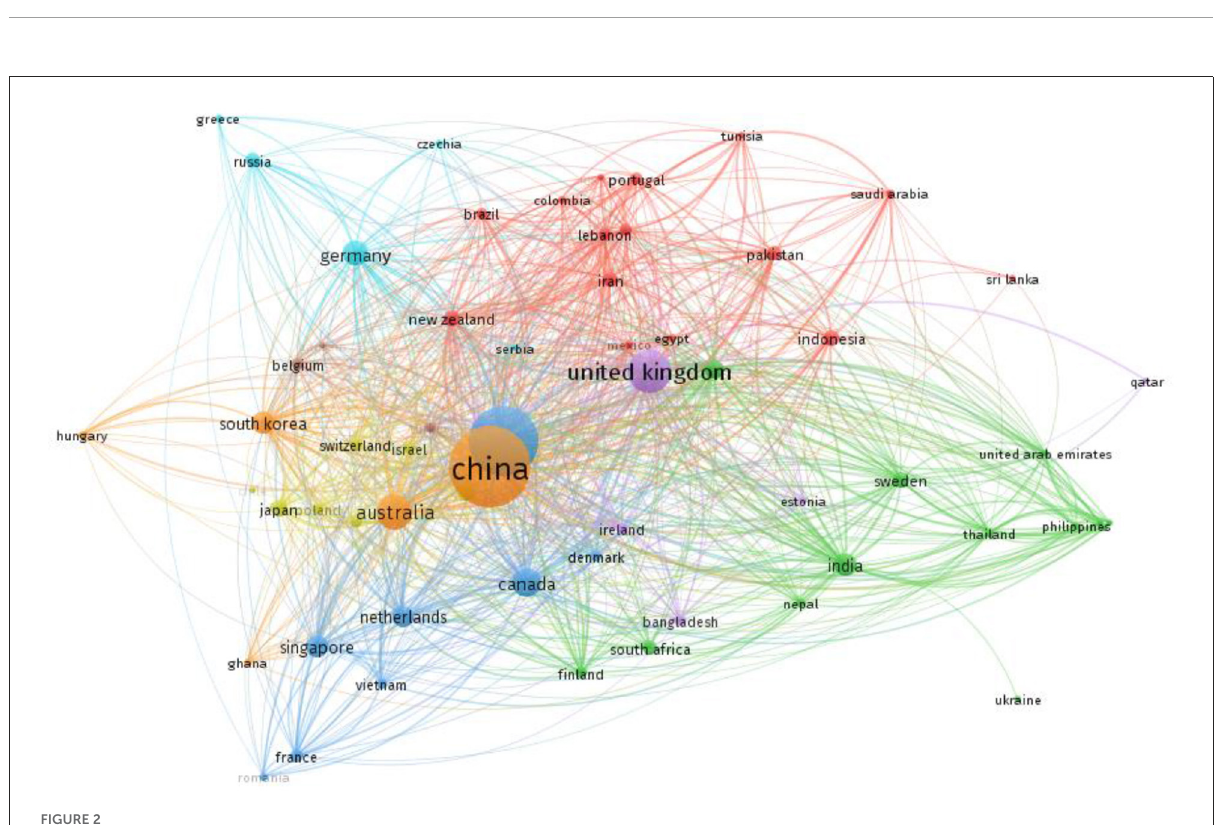
FIGURE2 Articles published in term of